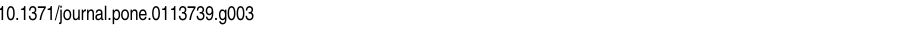
Figure 3. Myocyte CSA. C: control group; CS: cigarette smoke group; CSA: cross-sectional area C vs. CS p 5